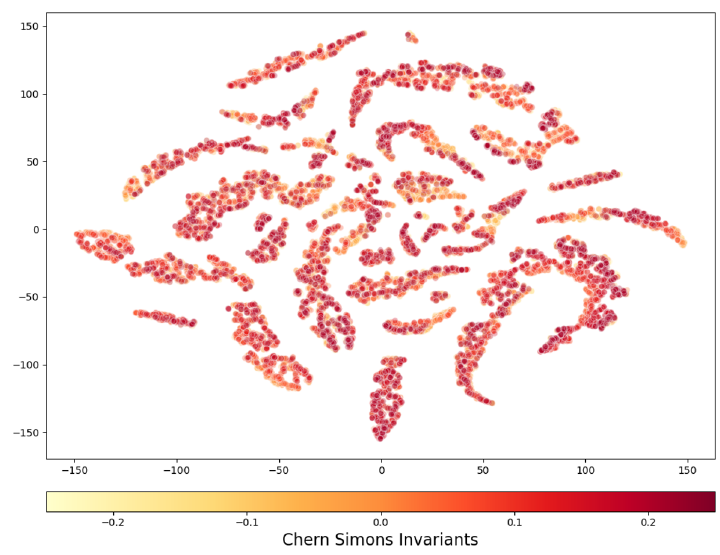
Figure 13 . t-SNE plot of 2000 Jones polynomials, colored by Chern-Simons invariant (default perplexity of 30